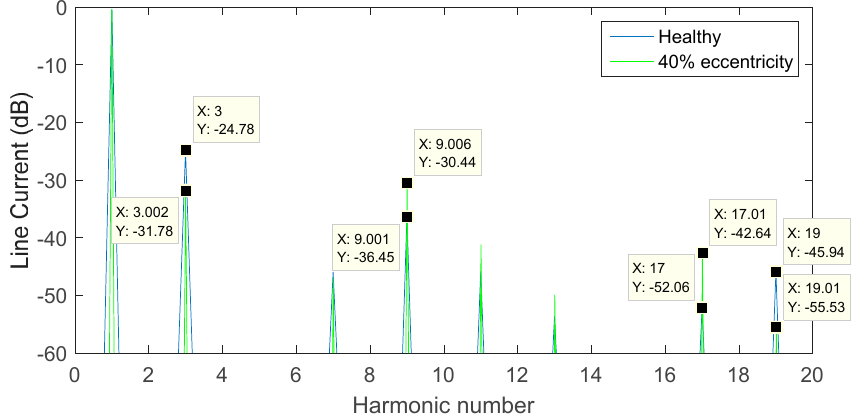
Figure 9. Low-current low-saturation operating conditions with a current angle of 30°. Spectral content of the line currents. Healthy machine and faulty machine with 40% eccentricity.